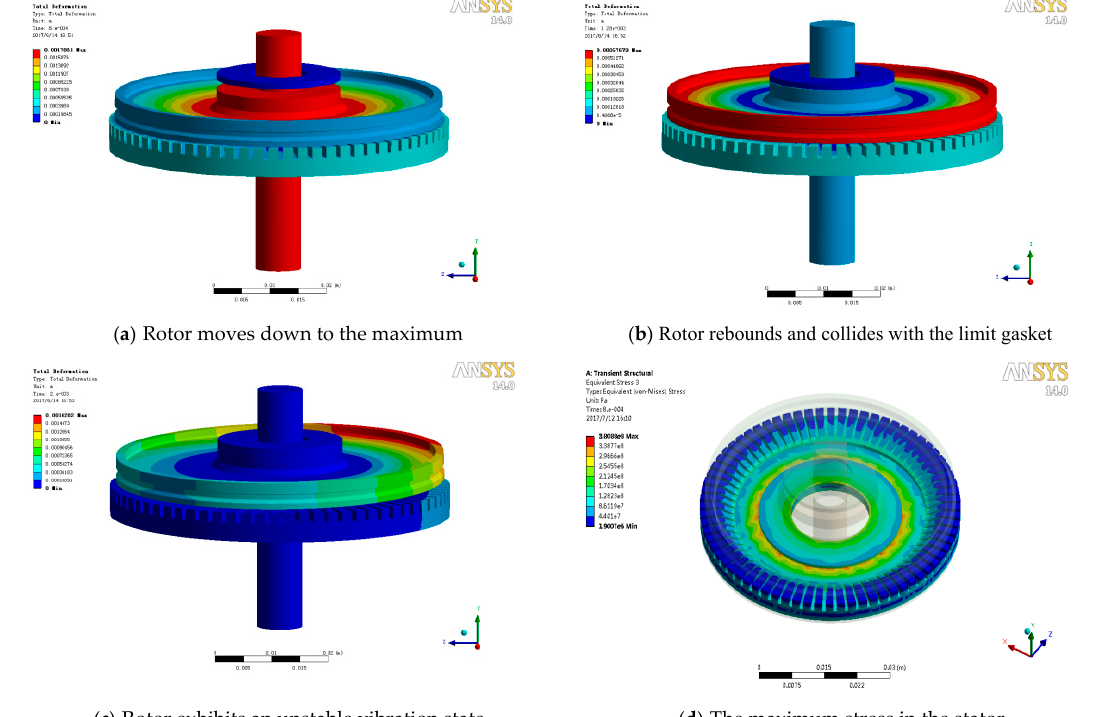
Figure 5. Dynamic response of an ultrasonic motor and stress distribution in a stator.